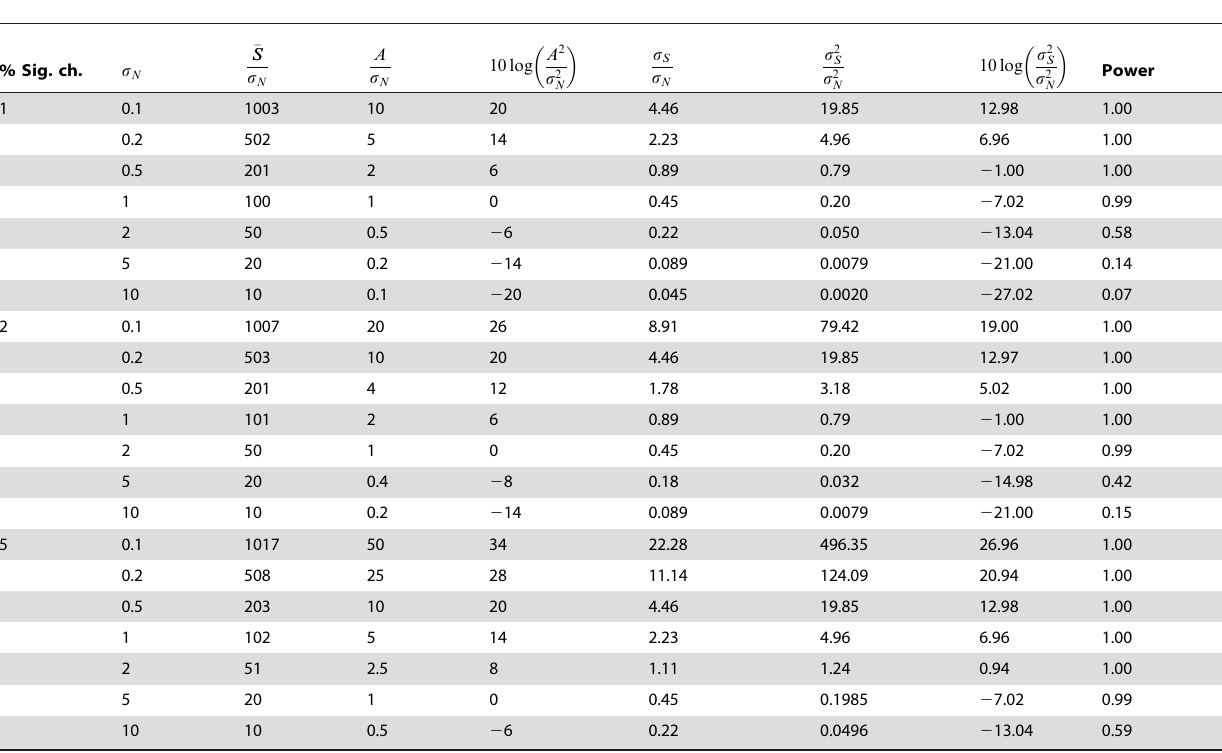
Table 1. Reference table for the different SNR/CNR definitions based on a block design.